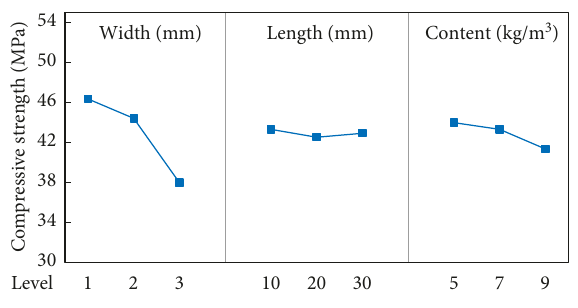
Figure 9: Main effect plot for compressive